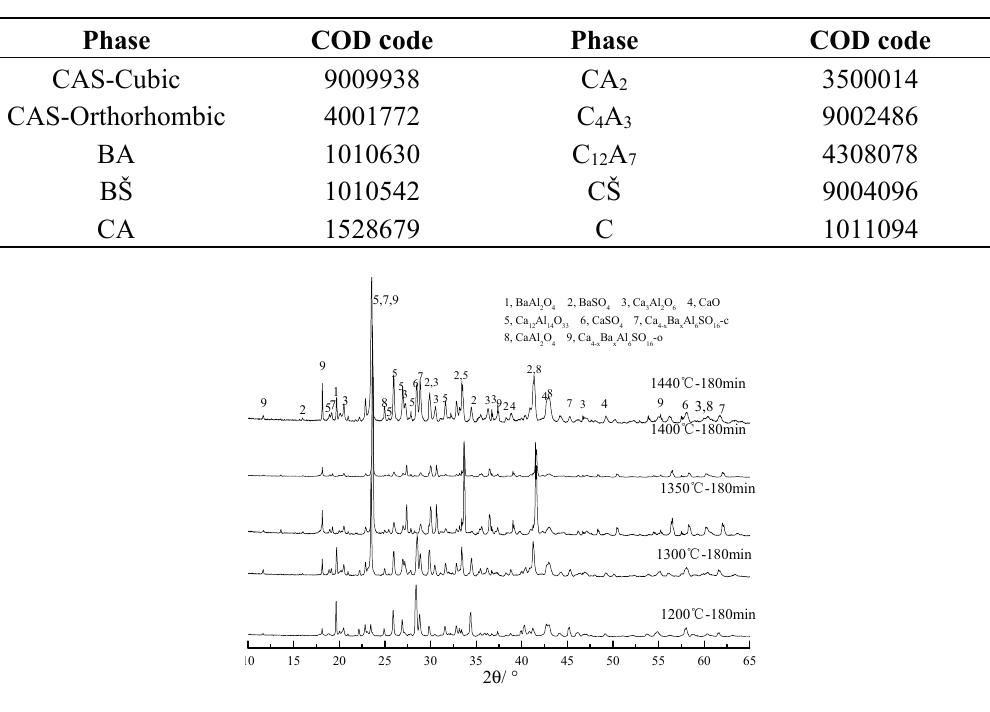
Table 1. Phase and COD code.